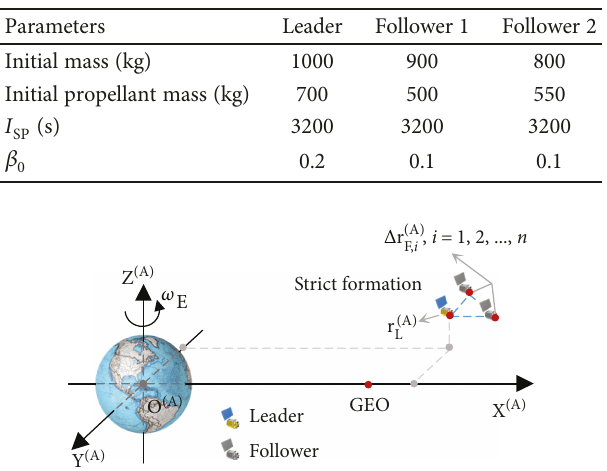
Figure 3: Strict formation in the rotating reference frame